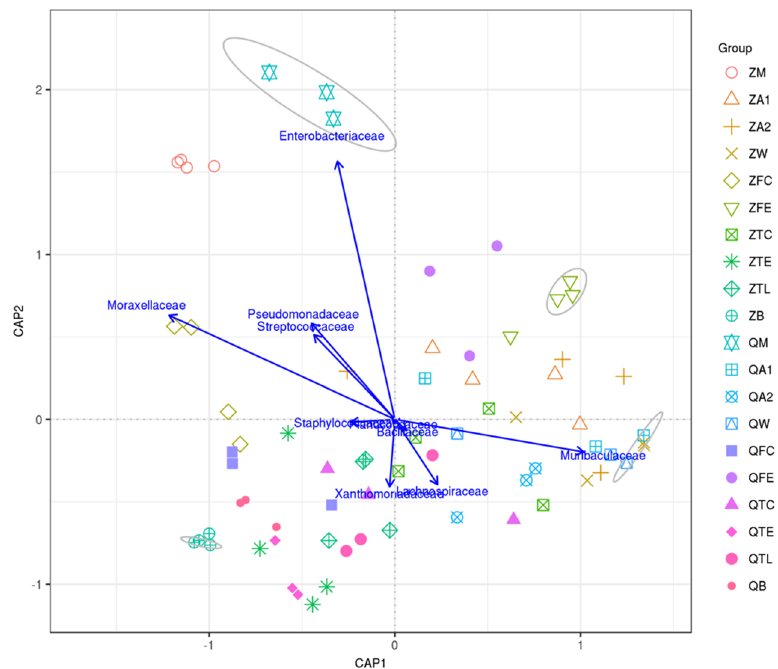
Figure 4. Canonical analysis of principal coordinates (CAP) illustrated the correlations of the 10 major OTUs within different samples. Samples enclosed in a gray circle are considered to be in the same group at a 70% similarity level.